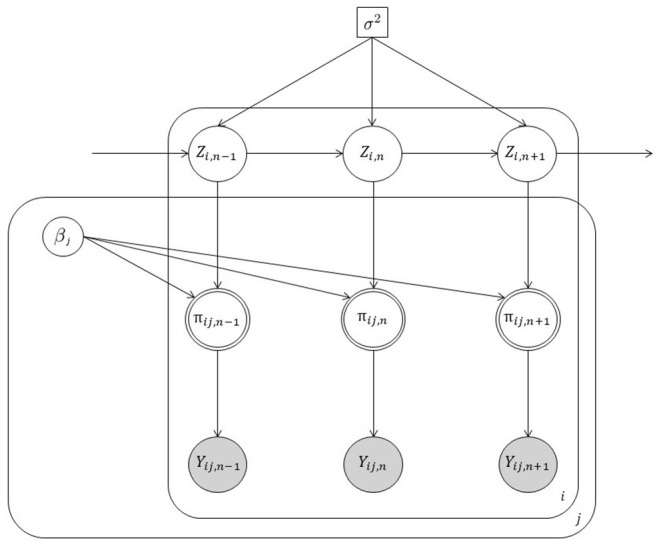
Graphical representation of our state-space model. Note that white circles represent unobserved random variables, white double circles indicate transformed random variables, gray circles are observed random variables. Finally, square objects depict scalar quantities. Loop over individuals i, trials j, and time steps n are represented by outer squares.